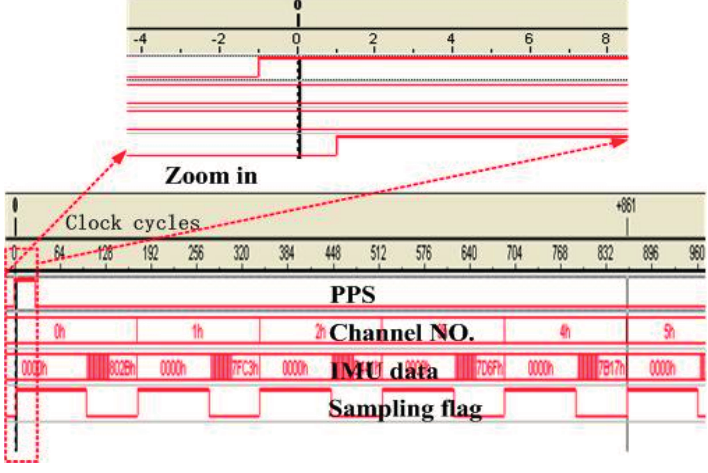
Figure 12. Sequence diagram of the IMU data sampling. PPS means pulse per